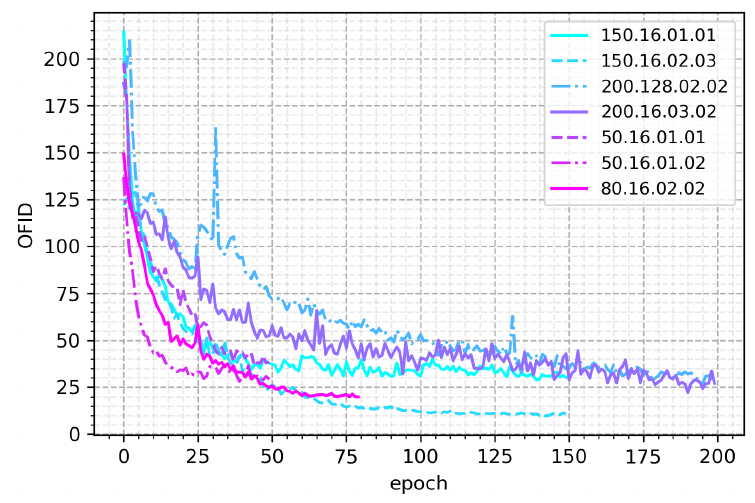
Figure 6. Training process: overall FID